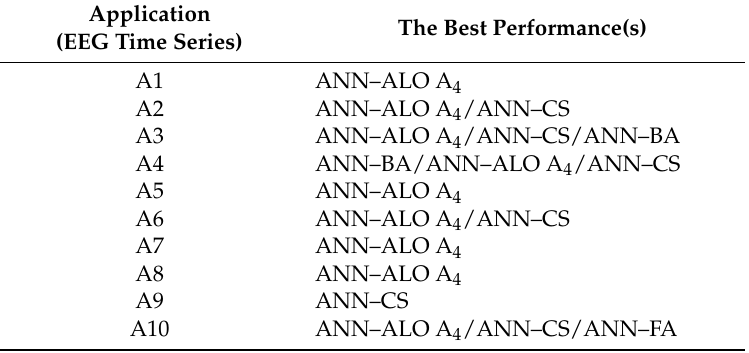
Table 13. Giacomini–White Test results for determining the best performance(s).